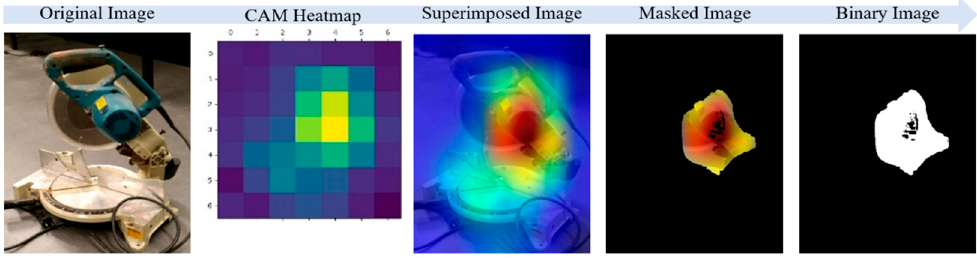
Figure 10. Original and the IDOL algorithm result images.